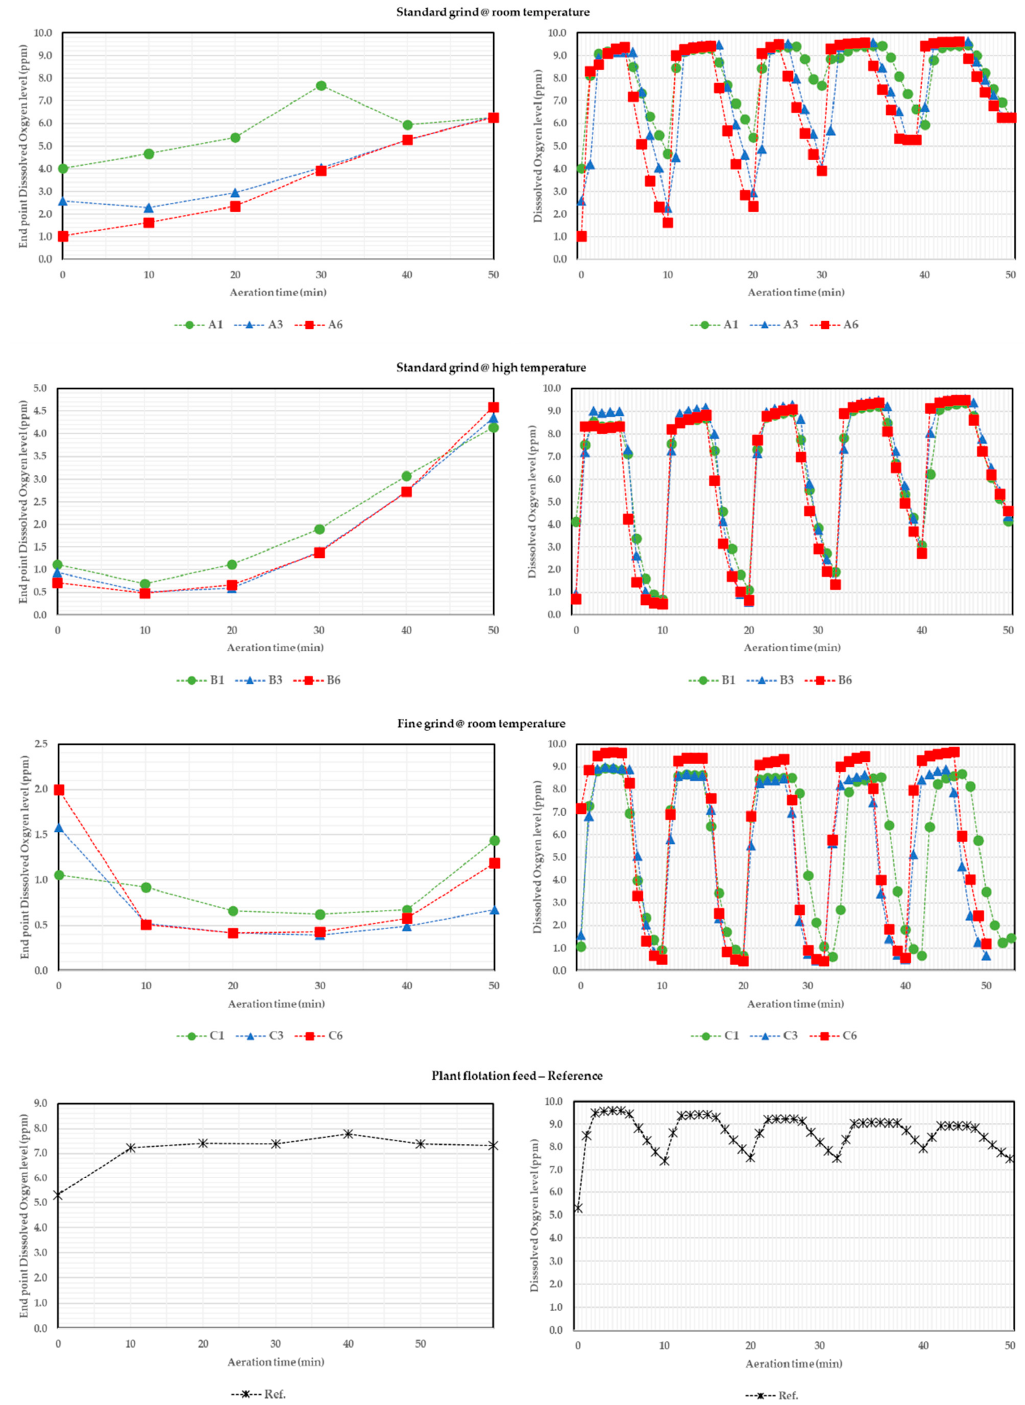
Figure 6. Dissolved oxygen levels at the end of each cycle and a full profile as a function of aeration time.